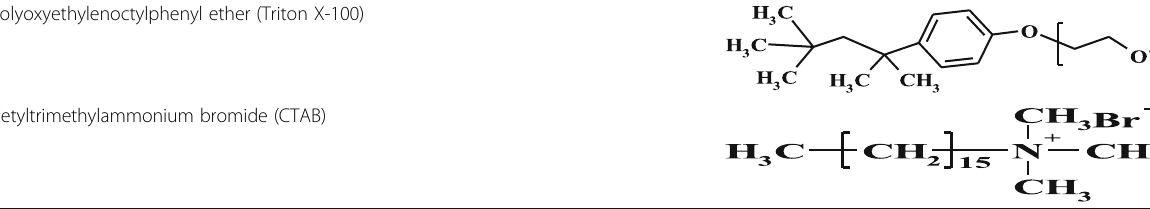
Table 1 Structural formulas of surfactants for synthesis from microemulsions Polyoxyethylenoctylphenyl ether (Triton Х -100)